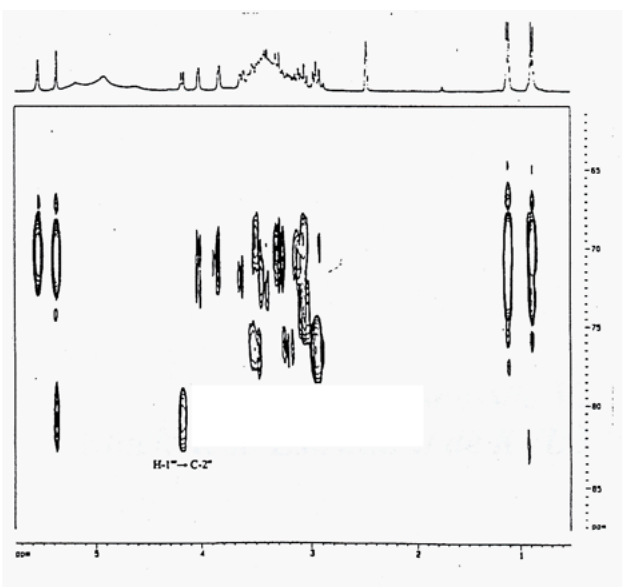
Figure S10: HMBC spectrum of sagittatin A (300 MHz; CD 3 OD). Magnification of 0.5 - 6.0/60 - 90 ppm